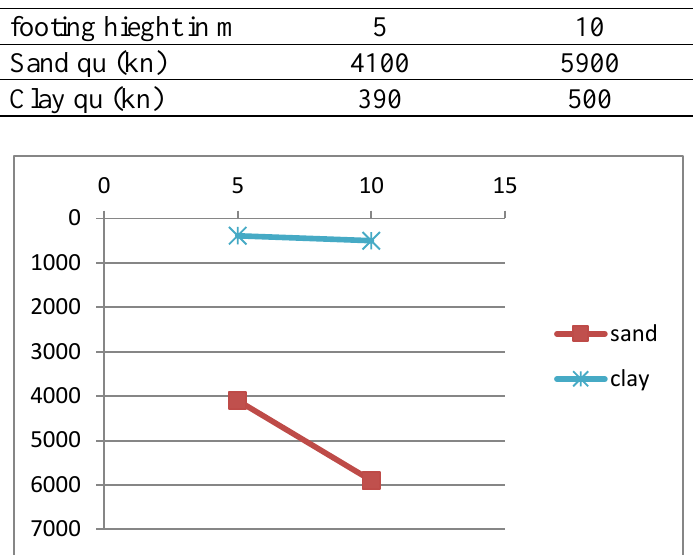
Table 1. Height of a ring Footing influencing Bearing Capacity.